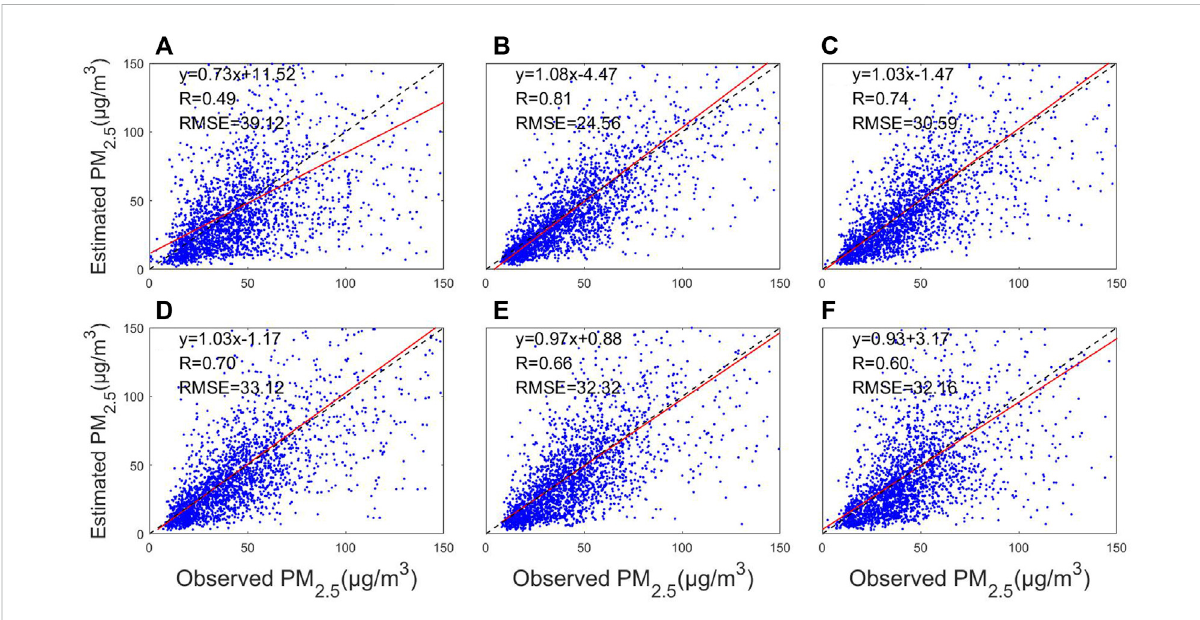
FIGURE 6 Comparison of observed and estimated PM 2.5 concentrations derived by the random forest with (A) AOD alone, (B) AOD plus four meteorological factors including speci fi c humidity, wind speed, surface air temperature, and sea level pressure, (C) AOD plus speci fi c humidity, (D) AOD plus surface air temperature, (E) AOD plus sea level pressure, and (F) AOD plus wind speed. Meteorological variables from ERA5 reanalyses are used as input. The regression functions and R are shown on each panel. Results based on MERRA-2 reanalyses are shown in Supplementary Figure